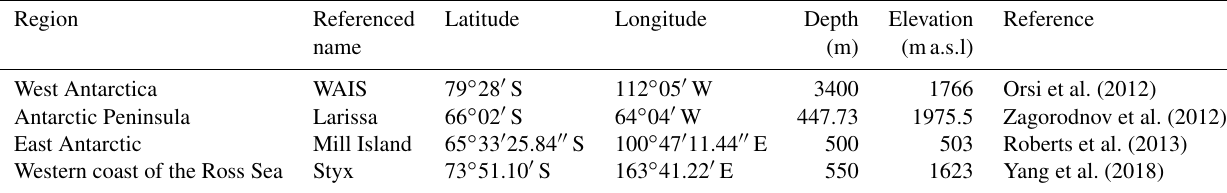
Table 1. Location of the four boreholes. Elevation is in meters above sea level (ma.s.l.). Depth is in meters (m). Region